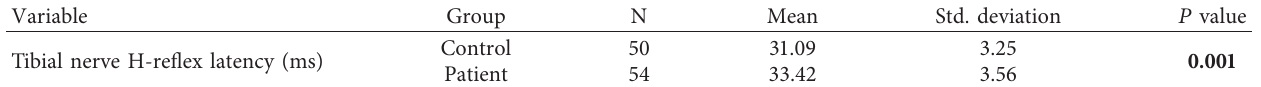
Table 5: H-reflex latency (patients group vs control group).